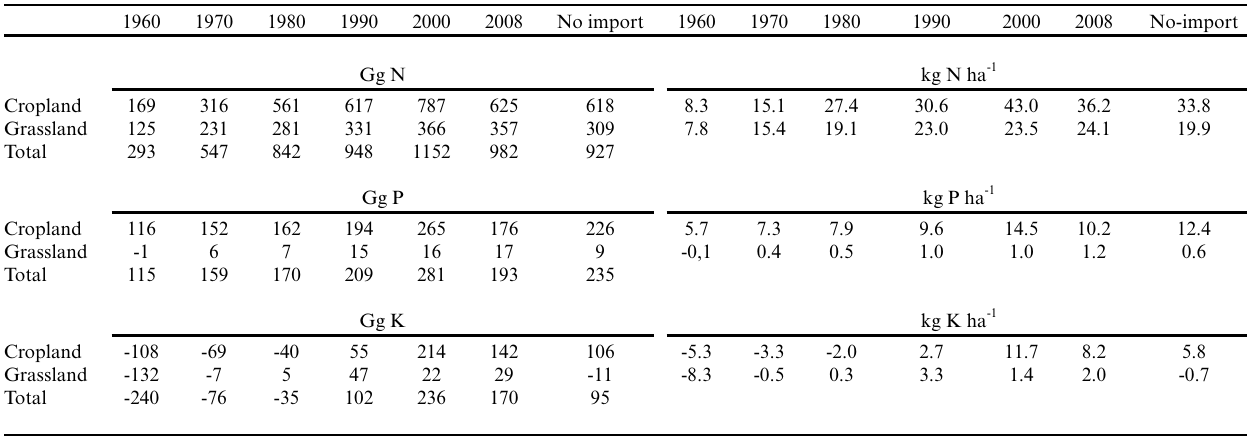
Table 2 . Nutrient balance (N, P, and K) for the different land uses and for the whole Spanish territory, 1960-2008 and no-import scenario.